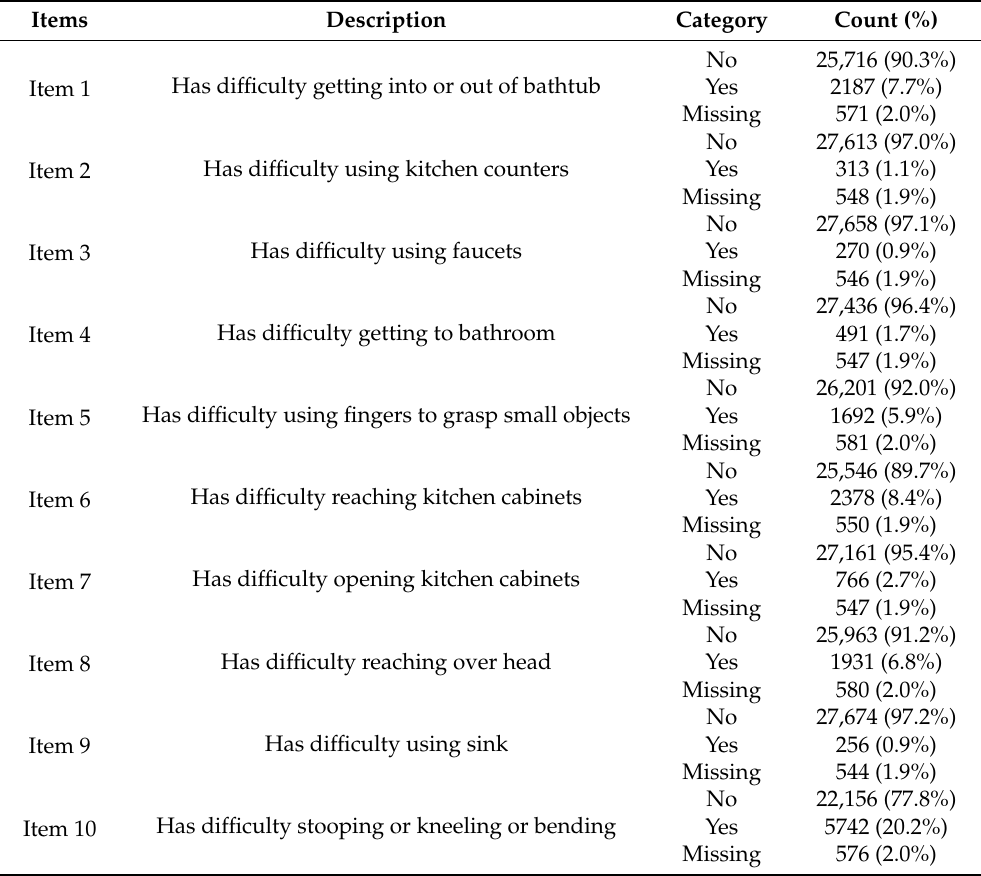
Table 1. Response Frequency of American Housing Survey Physical Function at Home